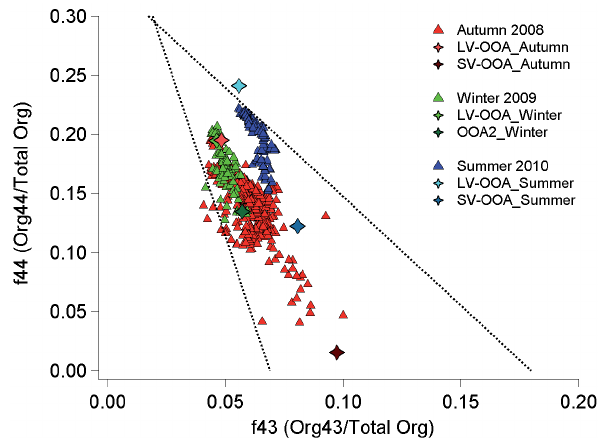
Fig. 4. Plot of the fraction of Org44 to total Organics (f44) against the fraction of Org43 to the total organics (f43) for each campaign. Each triangular point represents data averaged over a 60-min period. The star shaped points show f44 and f43 of each of the different organic species extracted from the total organic signal using PMF. The black dotted lines show the boundaries set by Ng et al.